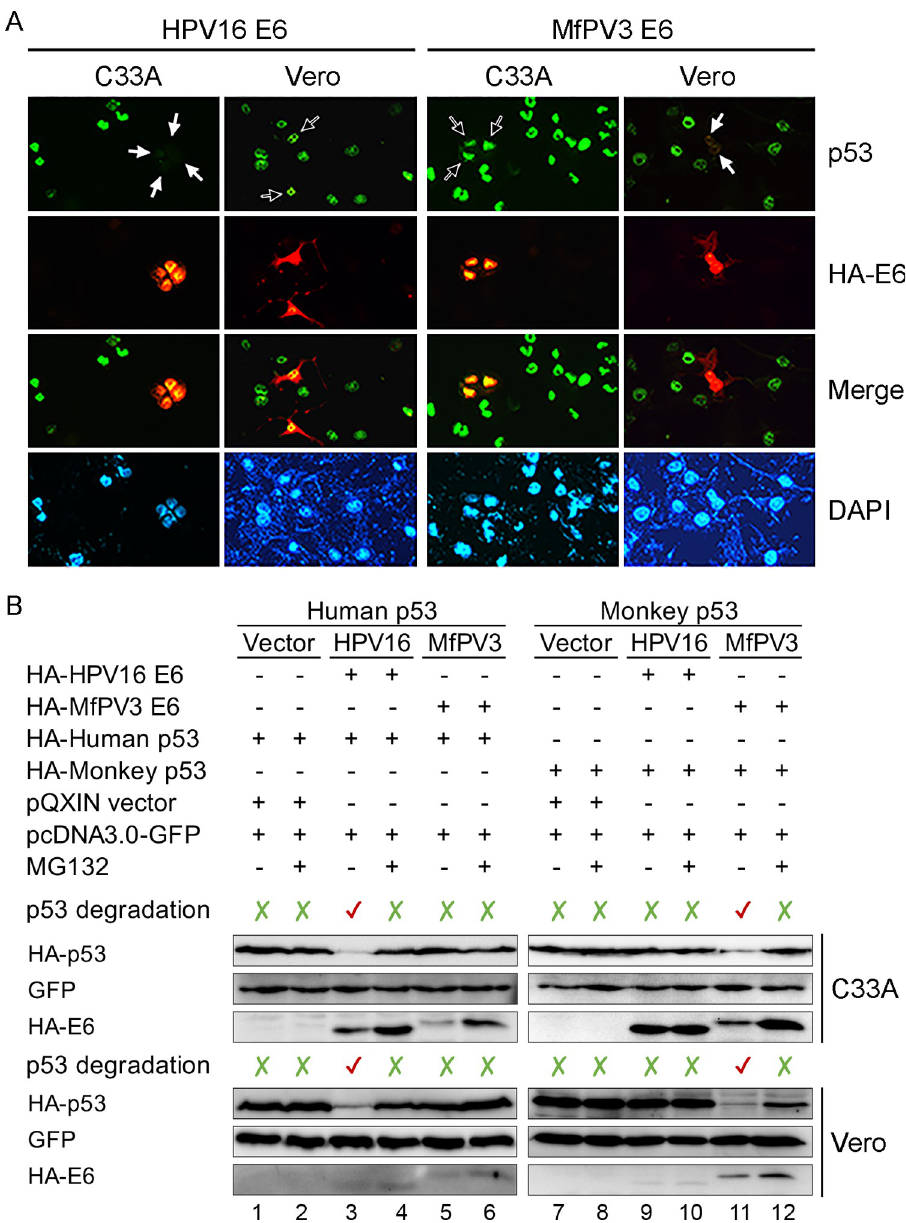
Fig 2. Primate PV E6-mediated p53 degradation. (A) Double immunofluorescence assay to localize the expression of E6 and p53 proteins in C33A (human) and Vero (green monkey) cells. Endogenous p53 and HA-tagged E6 proteins were stained green and red, respectively. Blank arrows indicate the location where E6 and p53 were co-expressed in cells, whereas white arrows denote E6-mediated p53 degradation. Nuclei of cells were counterstained with DAPI. Images were taken by an All-in-One fluorescence microscope with 400X magnification (Leica DM1000, Wetzlar, Germany). (B) Host-specific p53 degradation mediated by E6 proteins. HA-tagged p53 (human vs monkey) and E6 (HPV16 vs MfPV3) were co-transfected in vitro in C33A or Vero cells, respectively. Lanes 1, 3, 5, 7, 9, and 11 show results from co-transfected HA-p53 and vectors; lanes 2, 4, 6, 8, 10, and 12 show the p53 expression levels after treatment with MG132. The expression levels of green fluorescent protein (GFP) are also shown as a co-transfection control.